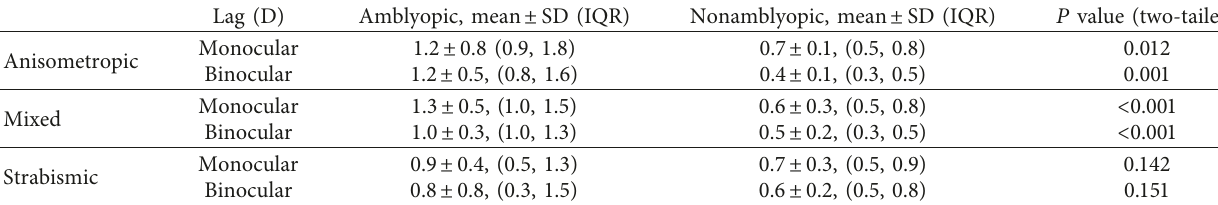
Table 2: Monocular and binocular lag of accommodation by type of amblyopia.